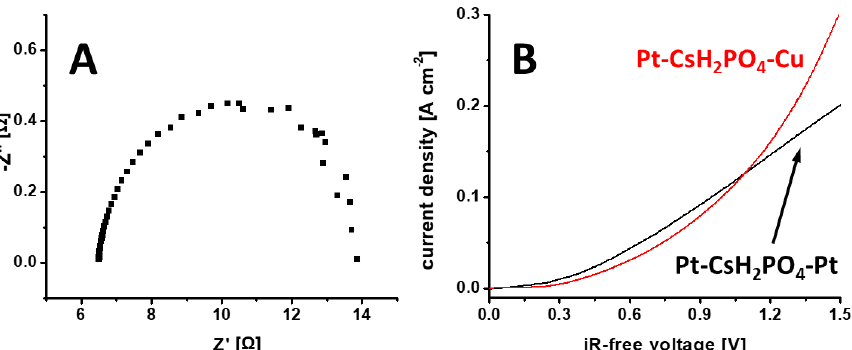
Figure 2. ( A ): Impedance spectrum for the Pt/CsH 2 PO 4 /Cu MEA for determining the proton conductivity (surface area: 1 cm 2 , thickness: 0.06 mm); ( B ): Current density–voltage curves for the Pt/CsH 2 PO 4 /Cu and Pt/CsH 2 PO 4 /Pt MEAs recorded under the same environment for the analysis of CO 2 reduction products (H 2 /CO 2 (0.4 atm H 2 O for both), 250 °C, scan rate: 10 mV·s -1 ).